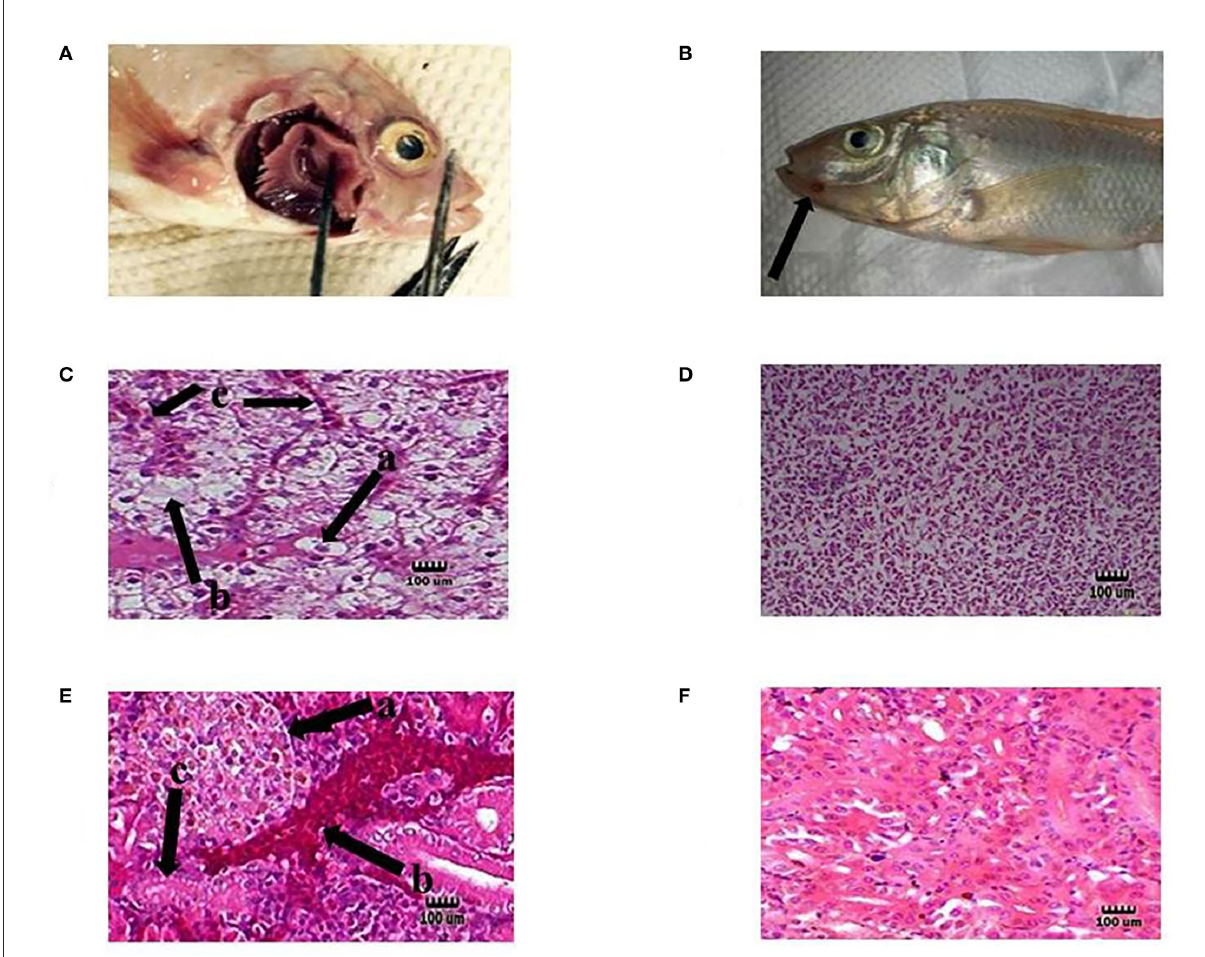
FIGURE3 Representative of the fish in each test group. Hemorrhage on the base of the pectoral fin (A) and near the mouth (B) in the infected tilapia (black arrow). Degeneration hepatocytes i.e., swelling [ C (a)], necrosis [ C (b)], and congestion blood vessels [ C (c)] in the liver of infected tilapia compared with normal liver tissue in the probiotic treated group without any infection (D) . Presence of corpuscles of stannius [ E (a)], congestion in renal vessel [ E (b)], and degeneration of tubular cells [ E (c)] in the kidney of infected fish compared with normal kidney tissue in the probiotic treated group without any infection by S. agalactiae (F) . H&E, Mag. 1,000 × . (Bar = 100 µ